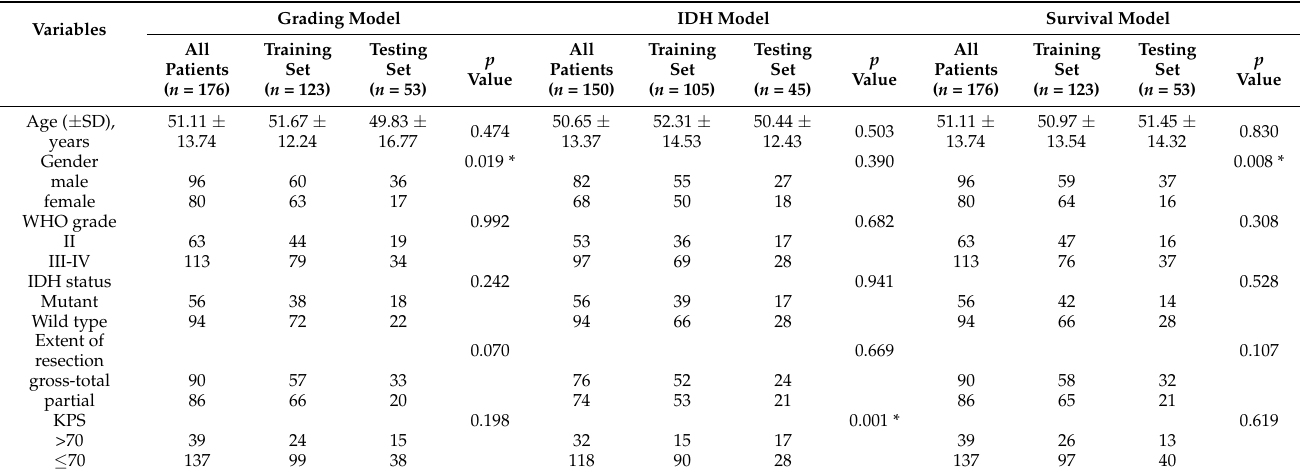
Table 1. Demographic and clinical data of glioma